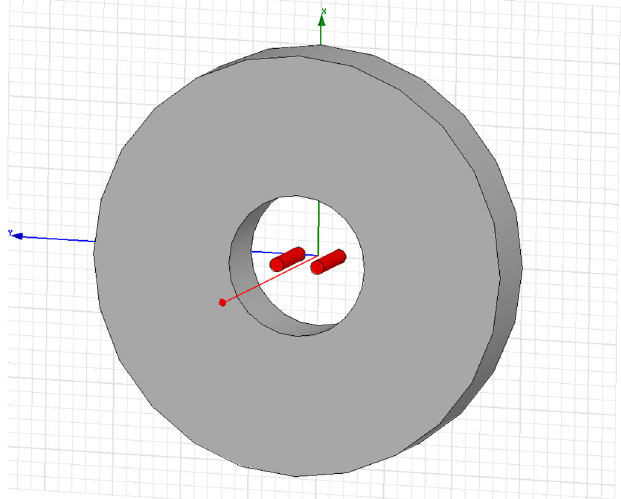
FIG. 6. (Color) 3D model used for the numerical simulations. A dipolar field is excited by the two wires (red) inside the lossy graphite cylinder